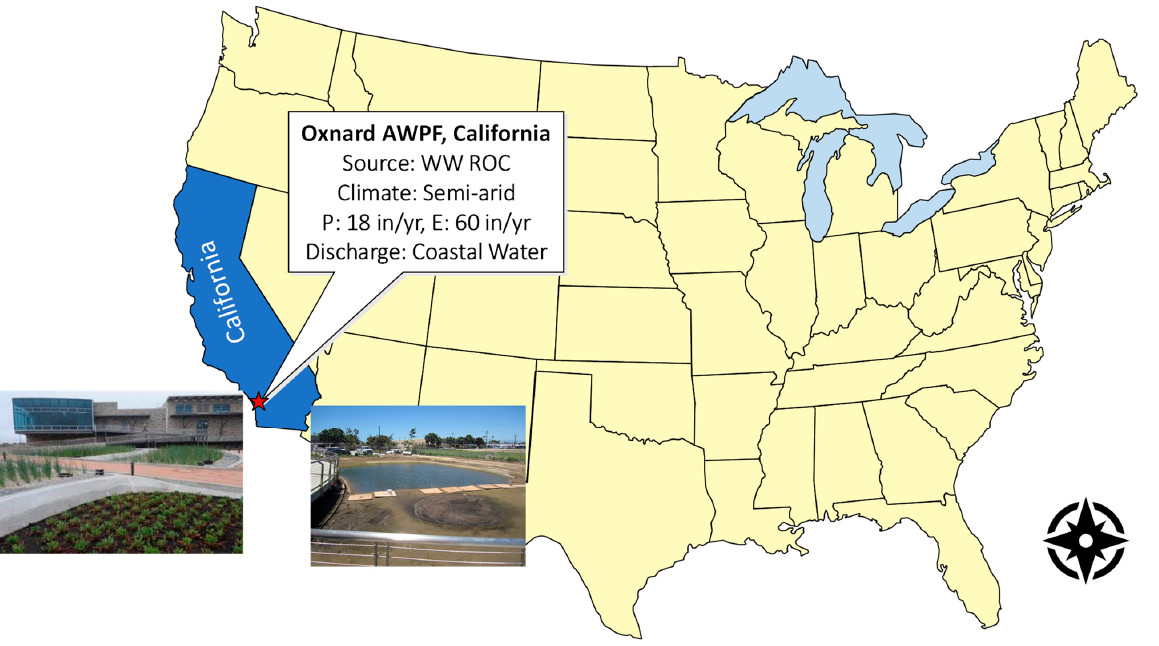
Figure 2. Location of the Oxnard AWPF in California on a map of the USA.